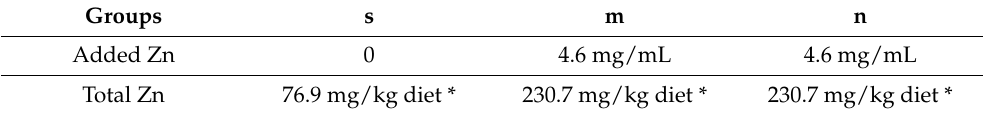
Table 1. Chemical composition of the diets containing different forms of Zn sources. Groups s m Added